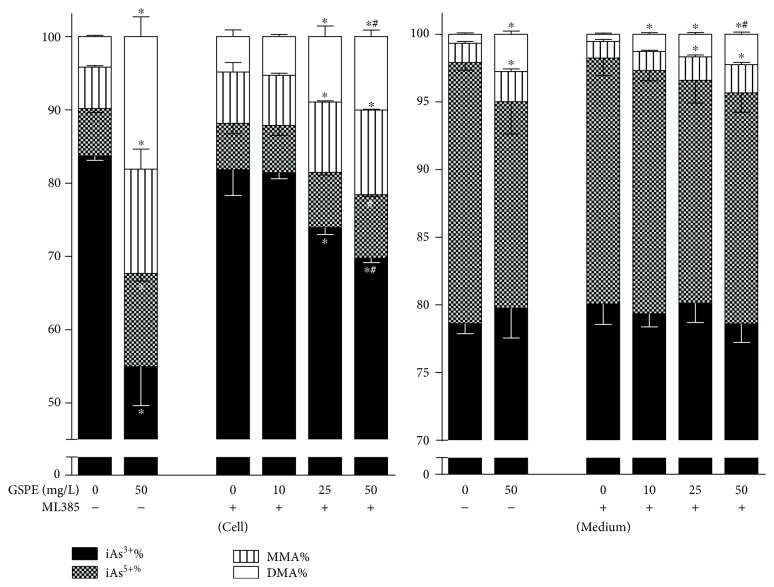
Proportion of arsenic compounds in Nrf2-suppressed cells (mean ± SD, n = 3). Nrf2-suppressed cells were treated with arsenic (25 μM) and grape seed procyanidin extract (GSPE; 0, 10, 25, and 50 mg/L) for 24 h. ∗Versus the GSPE (0 mg/L) group, P < 0.05; #versus the same intervention group in Nrf2 normal cells, P < 0.05. The proportions of various arsenic compounds in Nrf2-suppressed cells and its medium were calculated. The iAs3+ proportion was higher in Nrf2-suppressed cells treated with GSPE (50 mg/L) than in Nrf2 normal cells treated with the same dose. However, the DMA proportions in Nrf2-suppressed cells treated with GSPE (50 mg/L) and in medium were lower than that in Nrf2 normal cells and medium treated with the same dose.